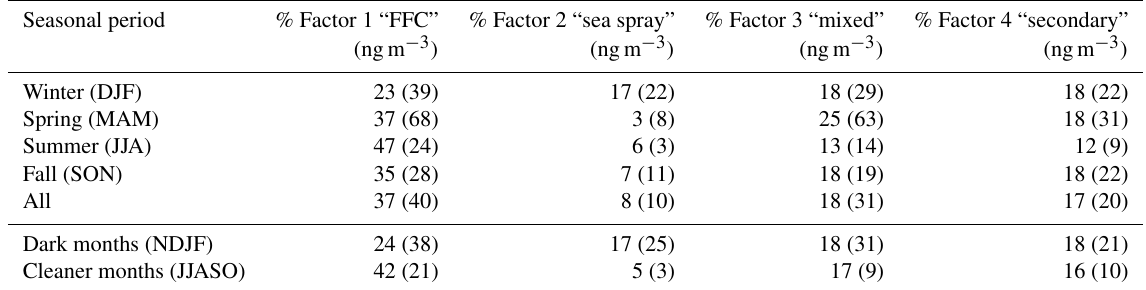
Table 4. Mean percentage contributions to OM from PMF factors (126 samples). The difference from 100% of the sum of factors is residual (approximately 20%). Values in parentheses are the factor mass concentrations in ngm − 3